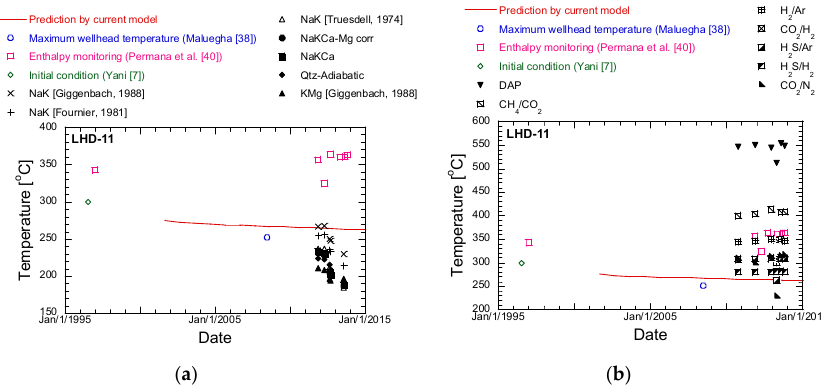
Figure 20. Comparison of reservoir temperature evolution prediction in LHD-11 among initial condition, wellhead temperature, enthalpy monitoring: ( a ) liquid geothermometer data; ( b ) gas geothermometer data.